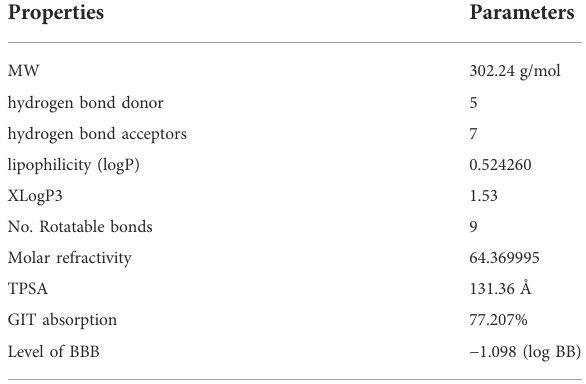
TABLE 1 Quercetin ’ s molecular and physicochemical properties.